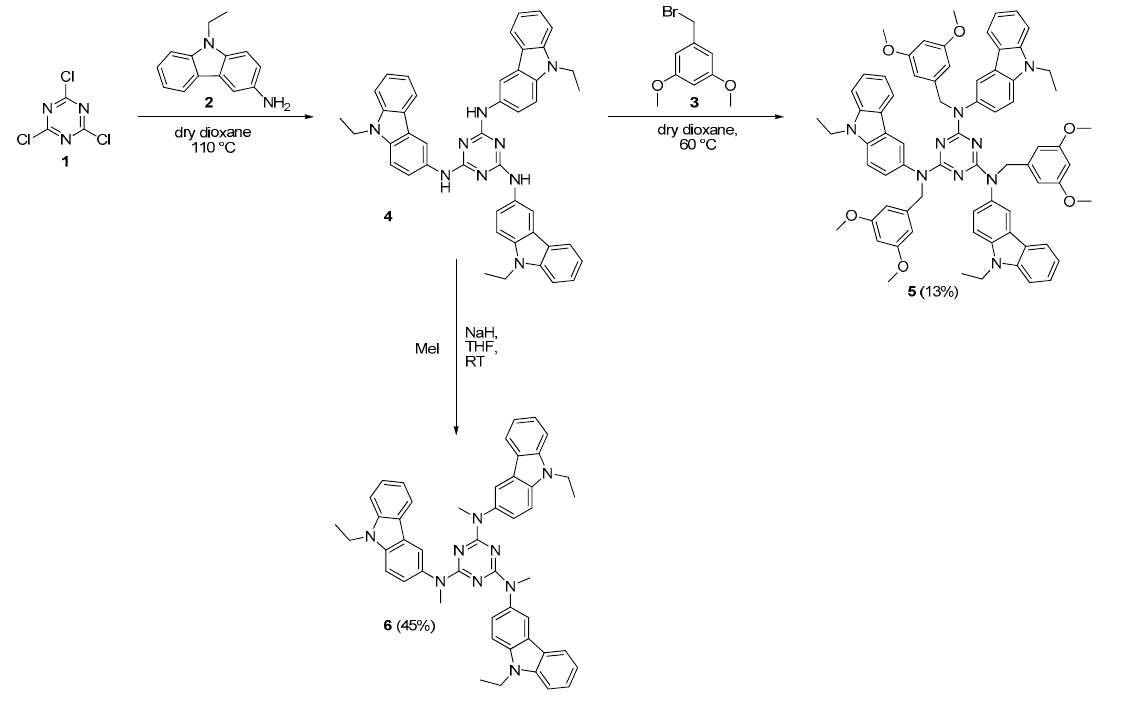
Scheme 1. The synthesis of compounds 4 – 6